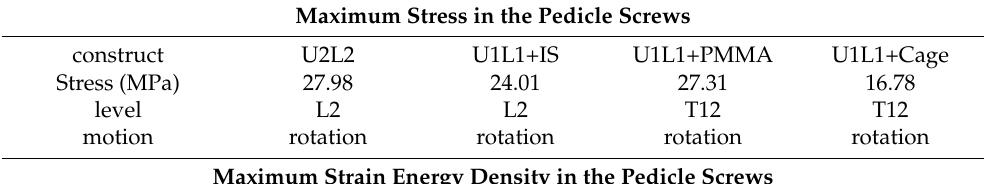
Figure 6. The maximum contact force at the proximal articular facets. The maximum facet contact force in the proximal level in flexion, extension, lateral bending, and axial rotation. Table 3. Maximum von Mises stress and strain energy in the pedicle screws.